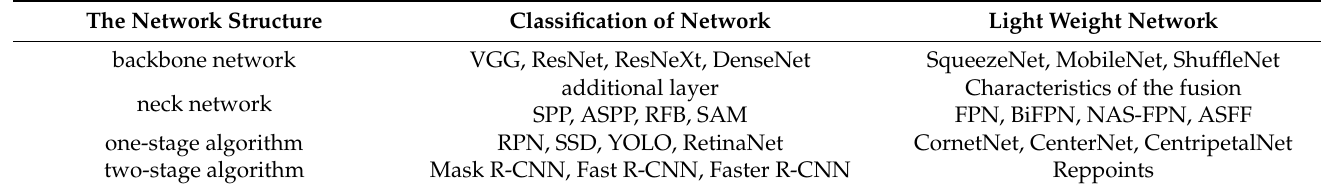
Table 1. Object detection algorithm classification.